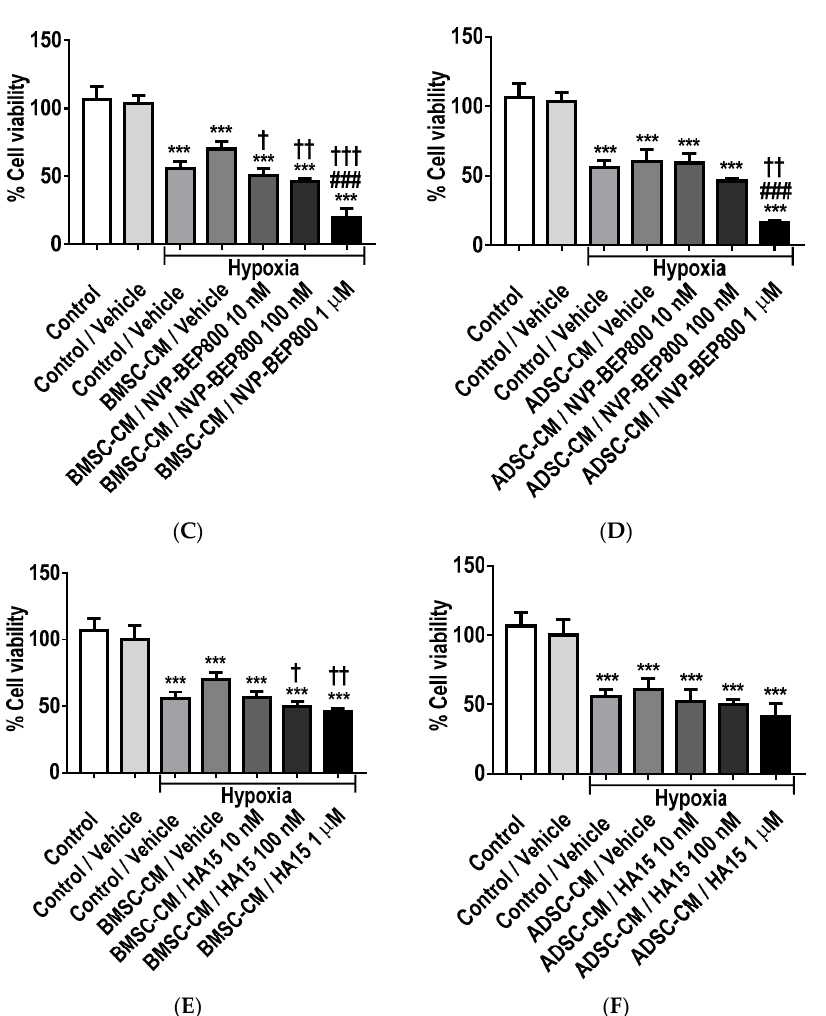
Figure 8. Cell viability of A549 cells treated with HSP70/90 family inhibitors, ( A , B ) VER155008 (HSP70 family; GRP75 and HSP70), ( C , D ) HA15 (GRP78) and ( E , F ) NVP-BEP800 (HSP90 family; GRP94, HSP90 and trap-1) in human MSC-CM during hypoxic (0.5% O 2 ) exposure for 24 h. The viability of A549 cells was assessed via MTT assay. Data presented as mean ± SD; n = 3 (*** p < 0.001 vs. normoxia control; and # p < 0.05, ### p < 0.001 vs. hypoxia control and † p < 0.05, †† p < 0.01, ††† p < 0.001 vs. BMSC-CM / vehicle or ADSC-CM / vehicle). The resulting data were statistically analysed using one-way ANOVA and Tukey’s multiple comparison test.